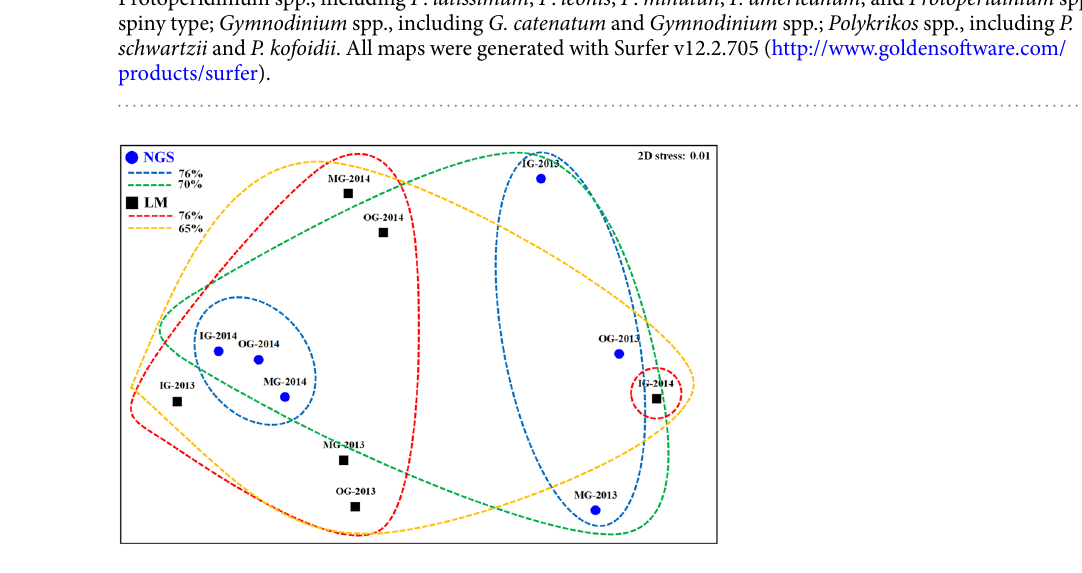
data). In particular, they occurred frequently in spring and summer. In the NGS analysis, the assemblage com- position is dominated by the Pentapharsodinium - Scrppsiella group, Gonyaulax spinifera , Woloszynskia group, Alexandrium group, and Gymnodinium aureolum . These dominant species detected by NGS were consistent